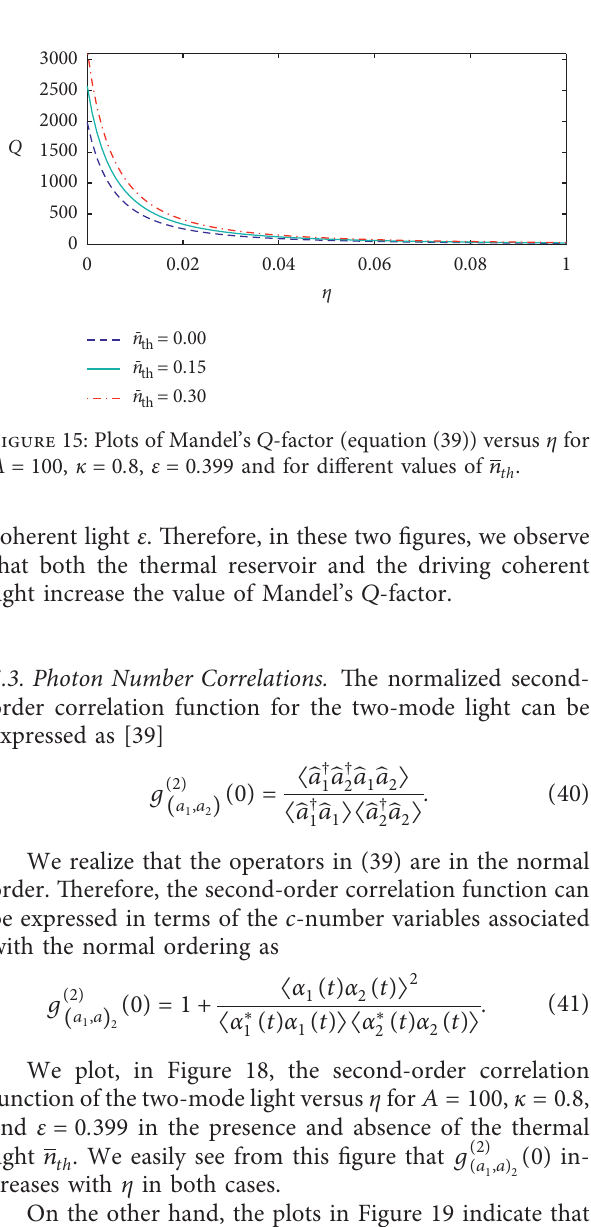
Figure 14: A plot of Mandel’s Q -factor (equation (39)) versus ε and η for A � 100, κ � 0 . 8, and n th � 0 . 15.